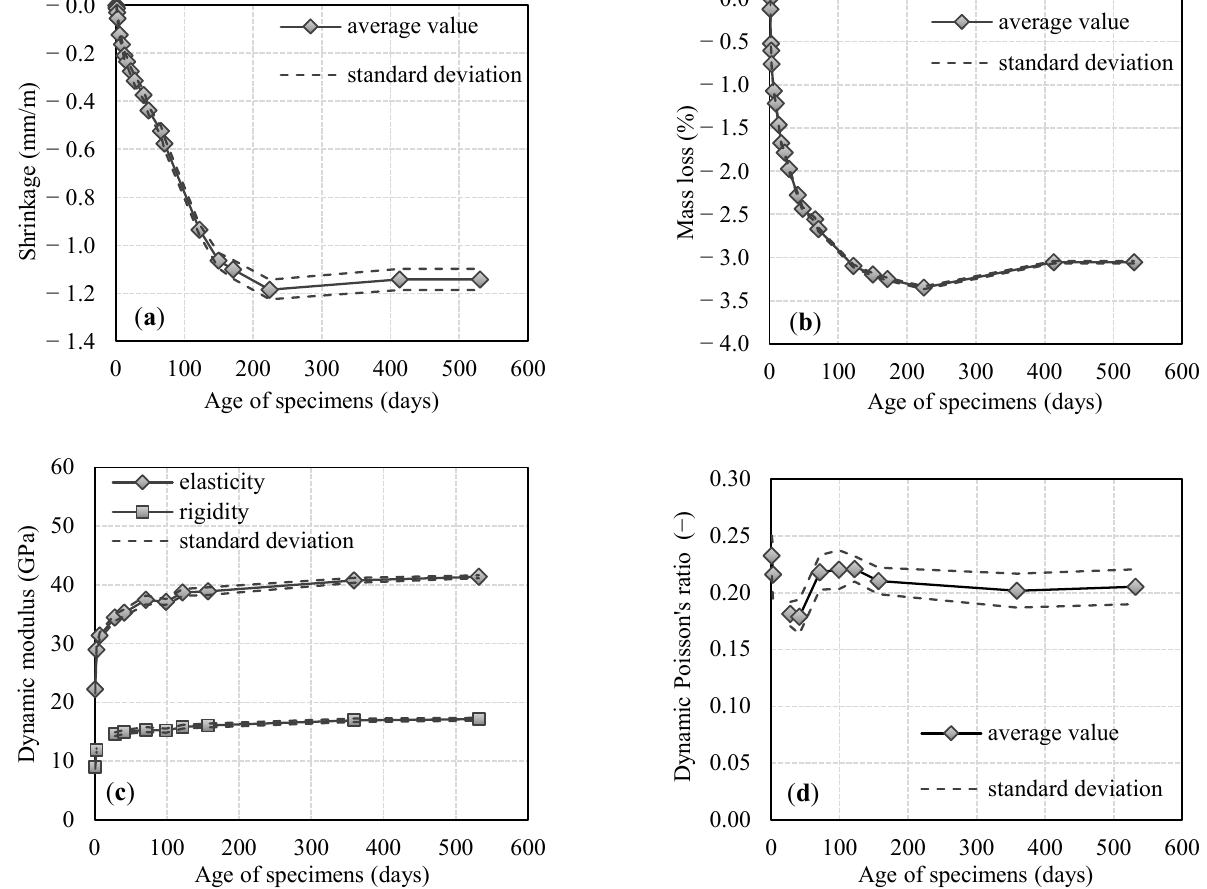
Figure 7. The mean values of shrinkage ( a ), mass loss ( b ) at RH of (55 ± 10)%, dynamic modulus of elasticity and rigidity ( c ), and dynamic Poisson’s ratio ( d ) at RH ≥ 95% of the investigated alkali-activated slag (AAS) composite during the specimen’s aging.